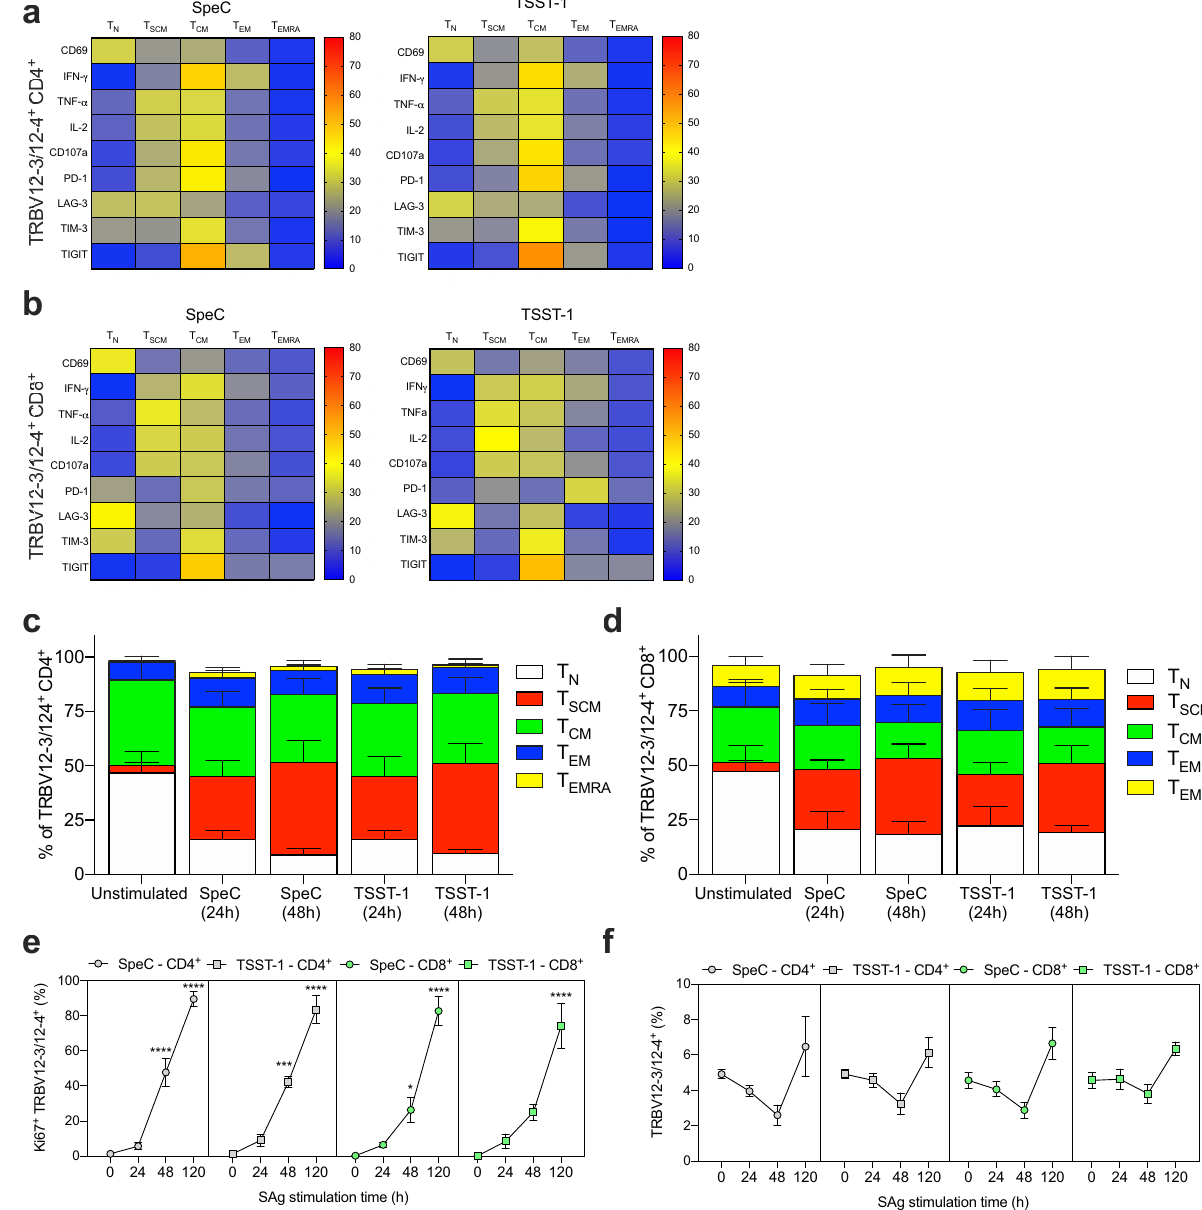
Fig. 4 SpeC and TSST-1 stimulate TRBV12-3/12-4 + CD4 + and CD8 + memory T cells. a , b Heatmaps showing the frequency (key) of TRBV12-3/12-4 + CD4 + ( a ) or CD8 + T cells ( b ) expressing CD69, IFN- γ , TNF- α , IL-2, CD107a, PD-1, LAG-3, TIM-3, or TIGIT across the T N , T SCM , T CM , T EM , and T EMRA subsets from human PBMCs stimulated for 24 h with SpeC or TSST-1. Concatenated data are shown ( n = 4). c , d Stacked bar charts showing the frequency of TRBV12-3/12-4 + CD4 + ( c ) or CD8 + T cells ( d ) across the T N , T SCM , T CM , T EM , and T EMRA subsets (key) from human PBMCs cultured in medium alone (unstimulated) or stimulated for 24 h or 48 h with SpeC or TSST-1 ( n = 4). Data are shown as mean ± SEM. e Frequency of Ki67 + cells among TRBV12-3/ 12-4 + CD4 + (gray fi lled symbols) or CD8 + T cells (green fi lled symbols) from human PBMCs cultured in medium alone (0) or stimulated for 24 h, 48 h, or 120 h with SpeC (circles) or TSST-1 (squares) ( n = 4). Data are shown as mean ± SEM. * p < 0.05, *** p < 0.001, **** p < 0.0001. One-way ANOVA with Tukey ’ s post-hoc test. f Frequency of TRBV12-3/12-4 + cells among CD4 + (gray fi lled symbols) or CD8 + T cells (green fi lled symbols) from human PBMCs cultured in medium alone (0) or stimulated for 24 h, 48 h, or 120 h with SpeC (circles) or TSST-1 (squares) ( n = 4). Data are shown as mean ± SEM.